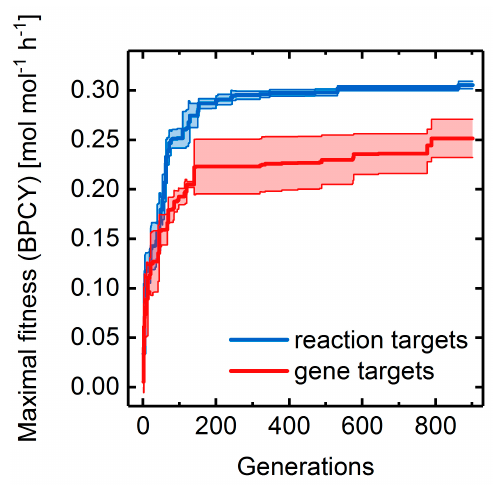
Figure 13. Fitness progressions of GA runs optimizing succinate overproduction in the E. coli i JO1366 model applying gene (red line) and reaction (blue line) deletions. Standard deviation among three replicate GA runs are illustrated as error bands.